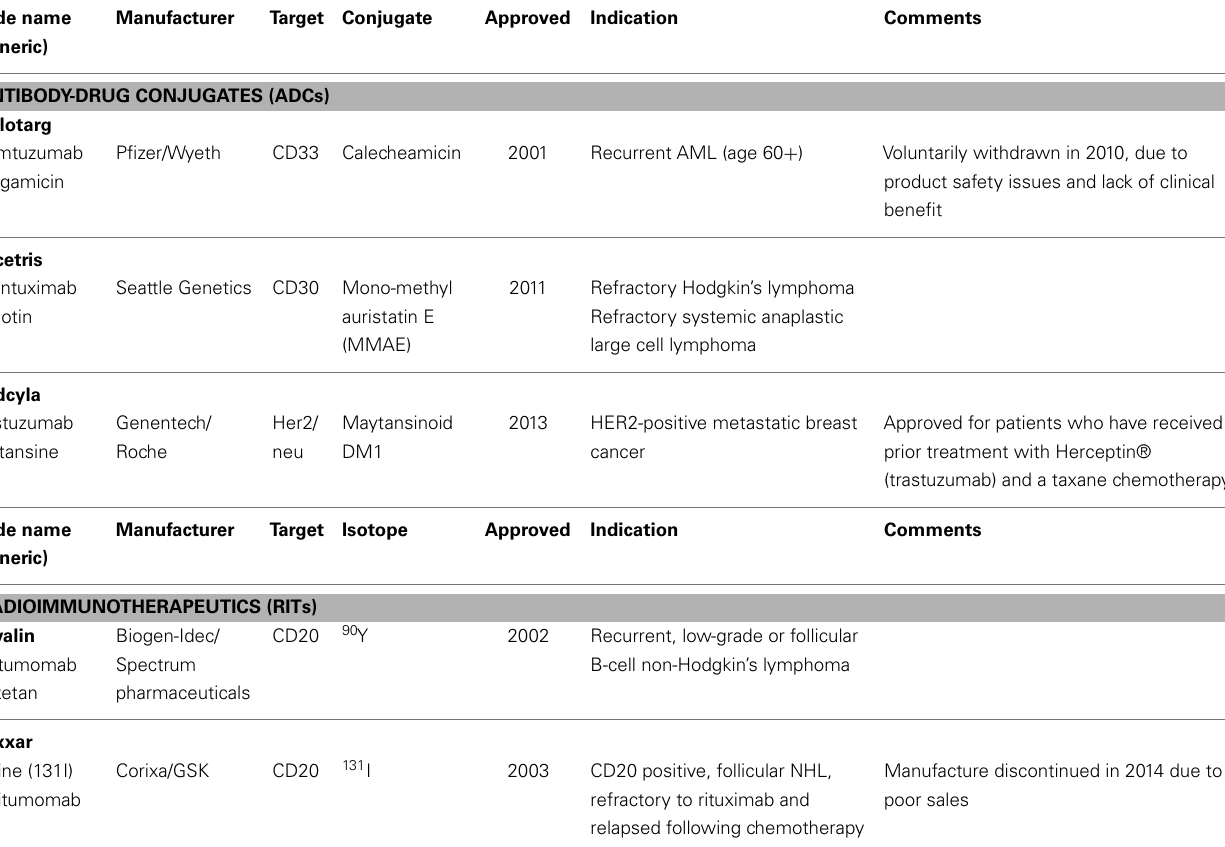
Table 4 | Examples of approved antibody-drug conjugates (ADCs) and radioimmunotherapeutics (RIT’s) in oncology